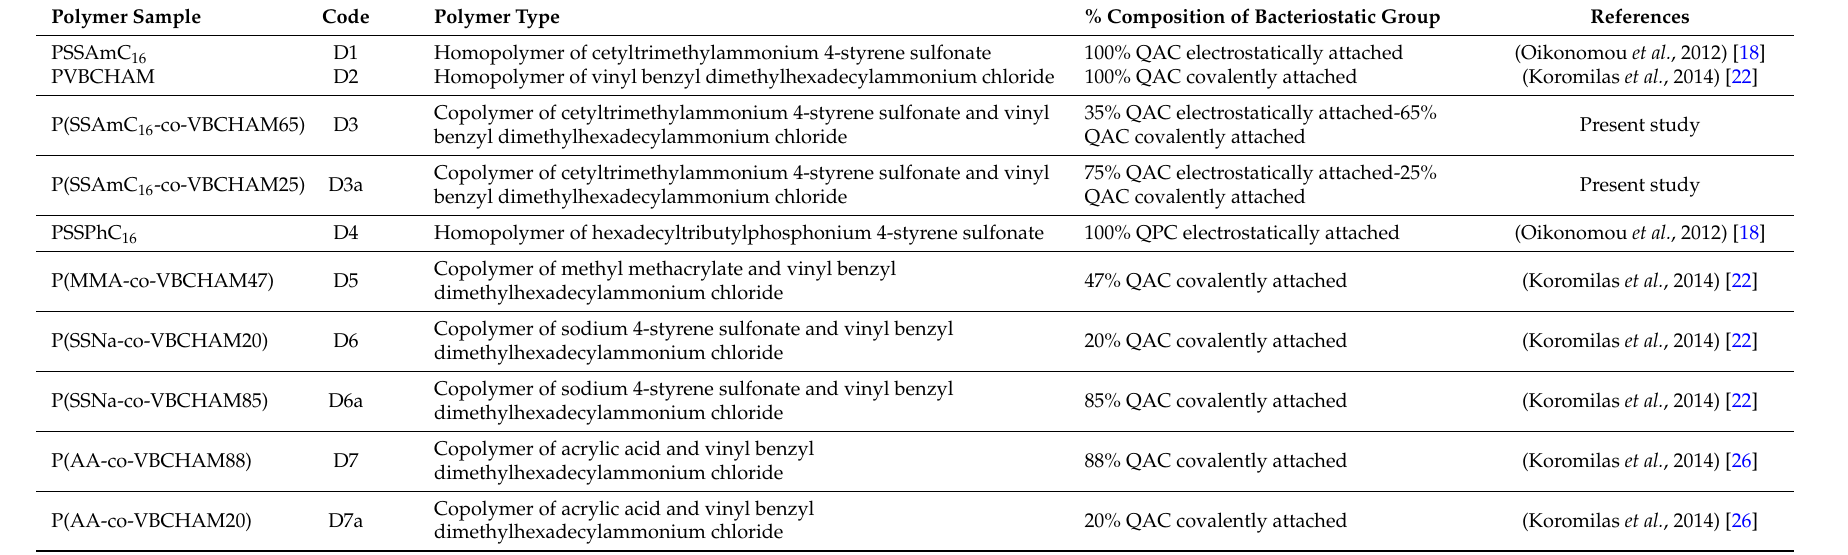
Table 1. Polymer samples that have been tested in terms of antibacterial